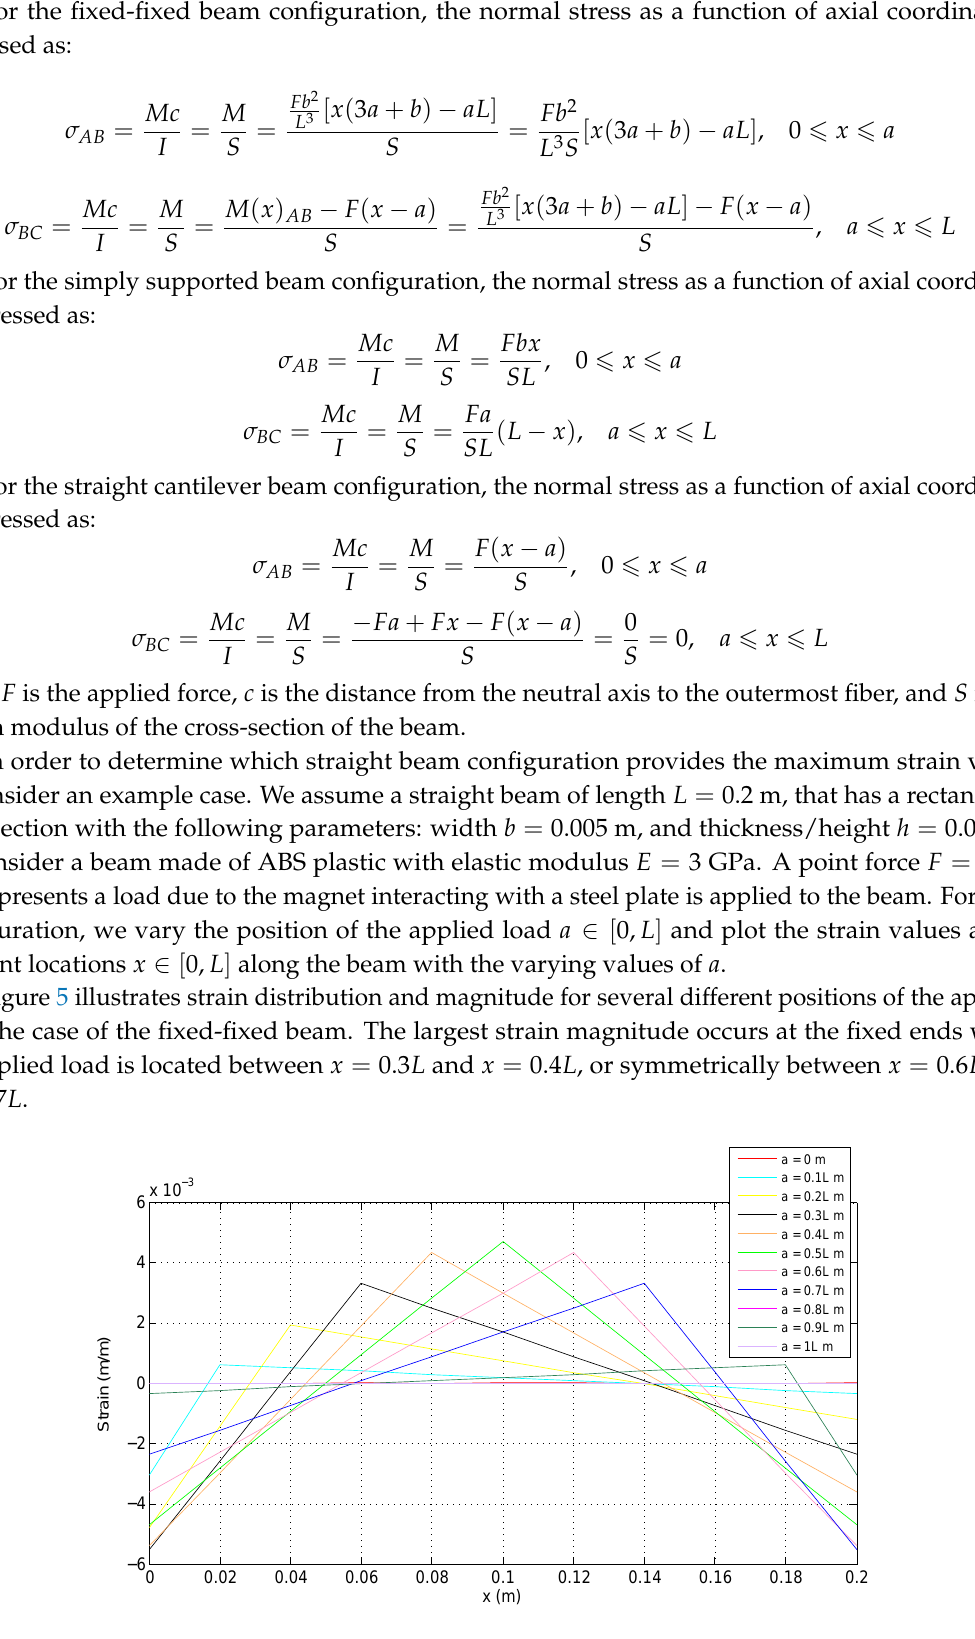
Figure 5. Strain values for the fixed-fixed beam